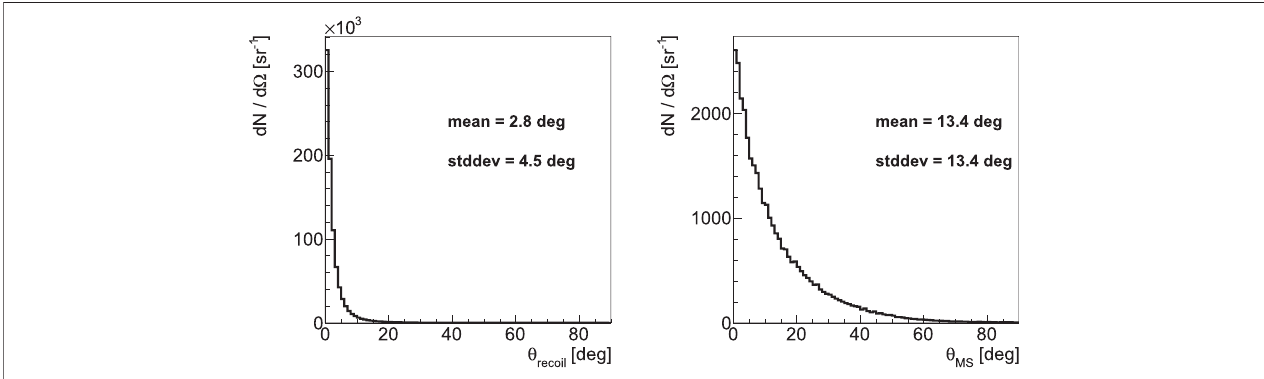
FIGURE 4 | Left: θ recoil distribution due to the nuclear recoil of the converter. Right: θ MS distribution due to the multiple scattering effect suffered by leptons within the converter. The distributions have been weighted with the solid angle 2 π sin ( θ ) d θ , with d θ (cid:3) 1 + · π / 180 + .